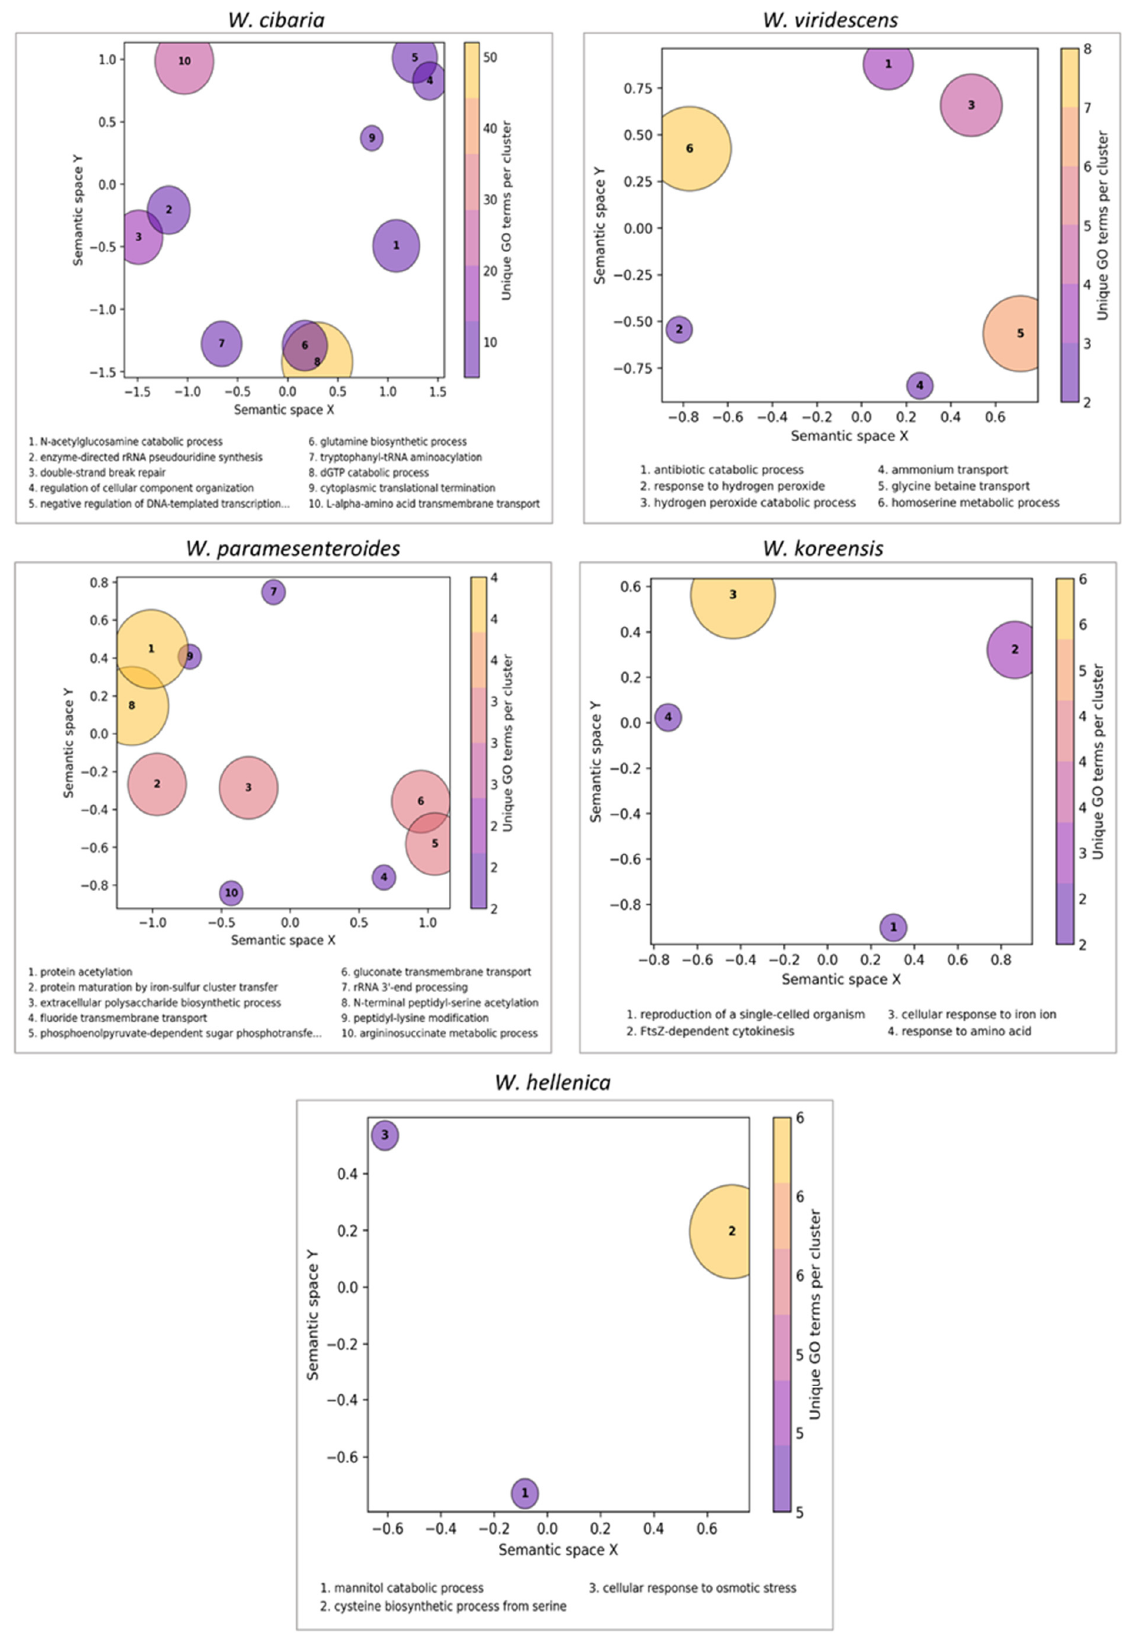
Figure 5. Clusters of unique Gene Ontology (GO) terms that were enriched in Weissella spp.